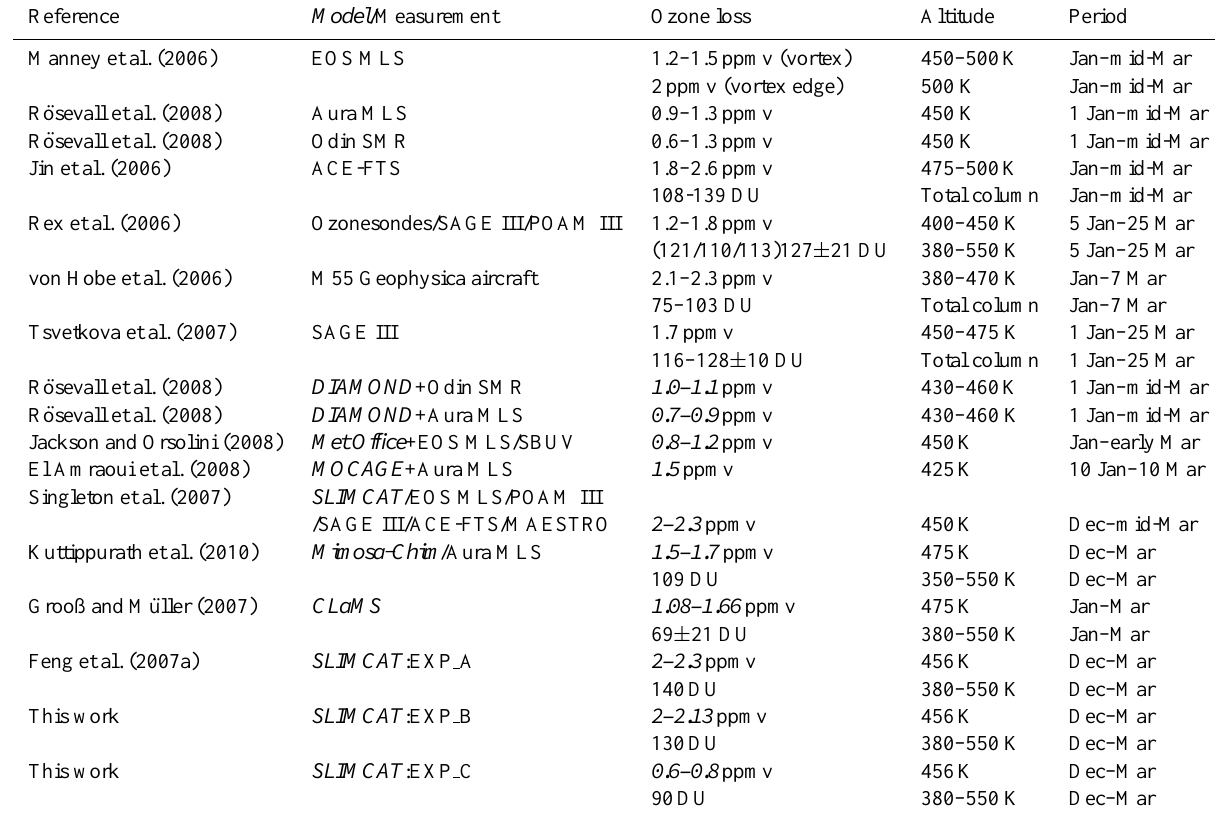
Table 2. Inferred maximum ozone loss for Arctic winter